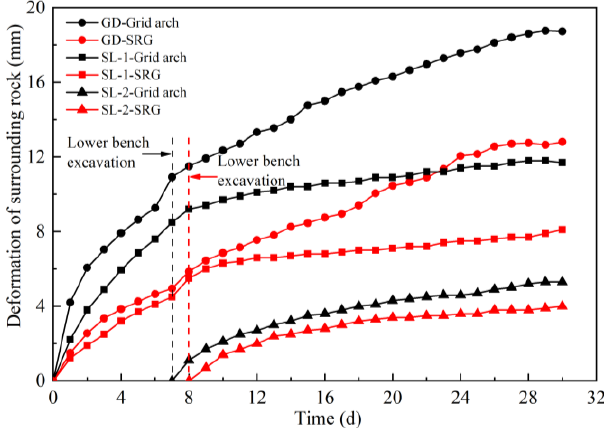
Figure 28. Duration curves of the displacement of the surrounding rock.